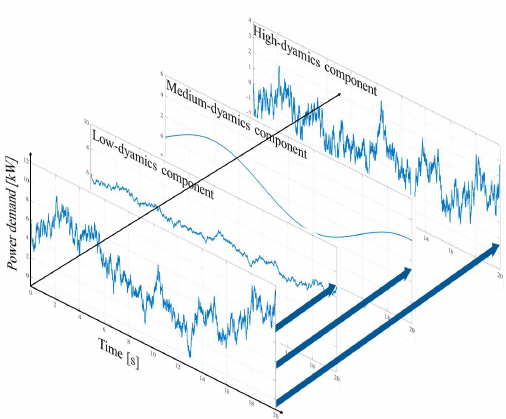
Figure 5. Frequency-based decomposition of power demand into low, medium, and high-frequency